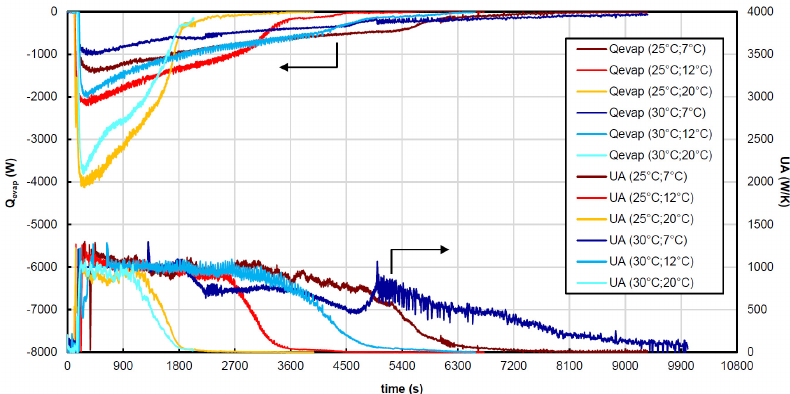
Figure 5. Evaporation exchanged power and UA trends by varying T (cid:2912)(cid:2915)(cid:2914),(cid:2919)(cid:2924) and T (cid:2913)(cid:2918)(cid:2933),(cid:2919)(cid:2924)